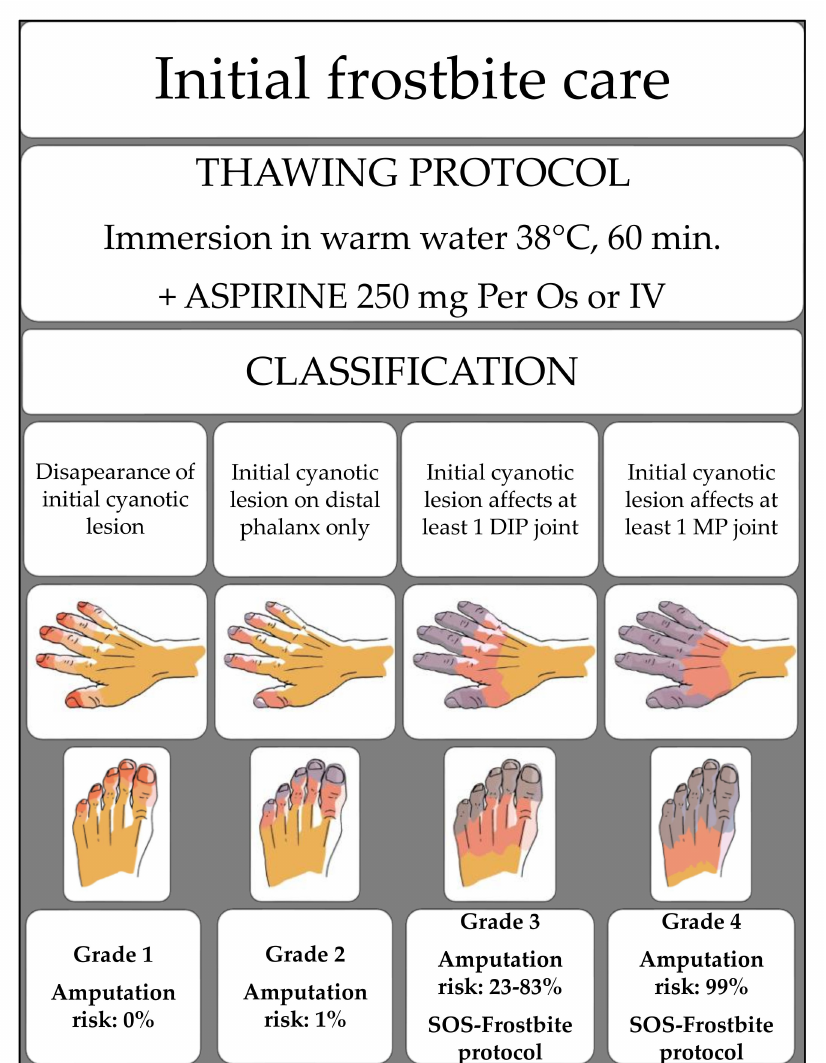
Figure 1. The frostbite classification by E. Cauchy ( drawings@copyright ifremmont